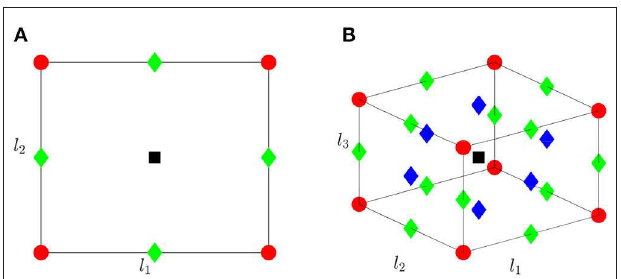
FIGURE 4 | Illustration of (A) two-element and (B) three-element system’s stability with element lengths restricted to [ l 0 ,1]. The global maximum is denoted by a black square, global minima by red circles, and saddle points by diamonds with green indicating an energy of 1 and blue an energy of 2.